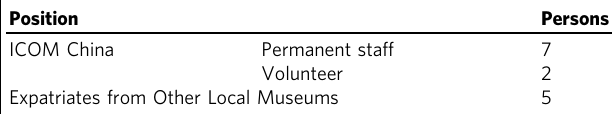
Table 1 Personnel of MPT-EXPO Organization